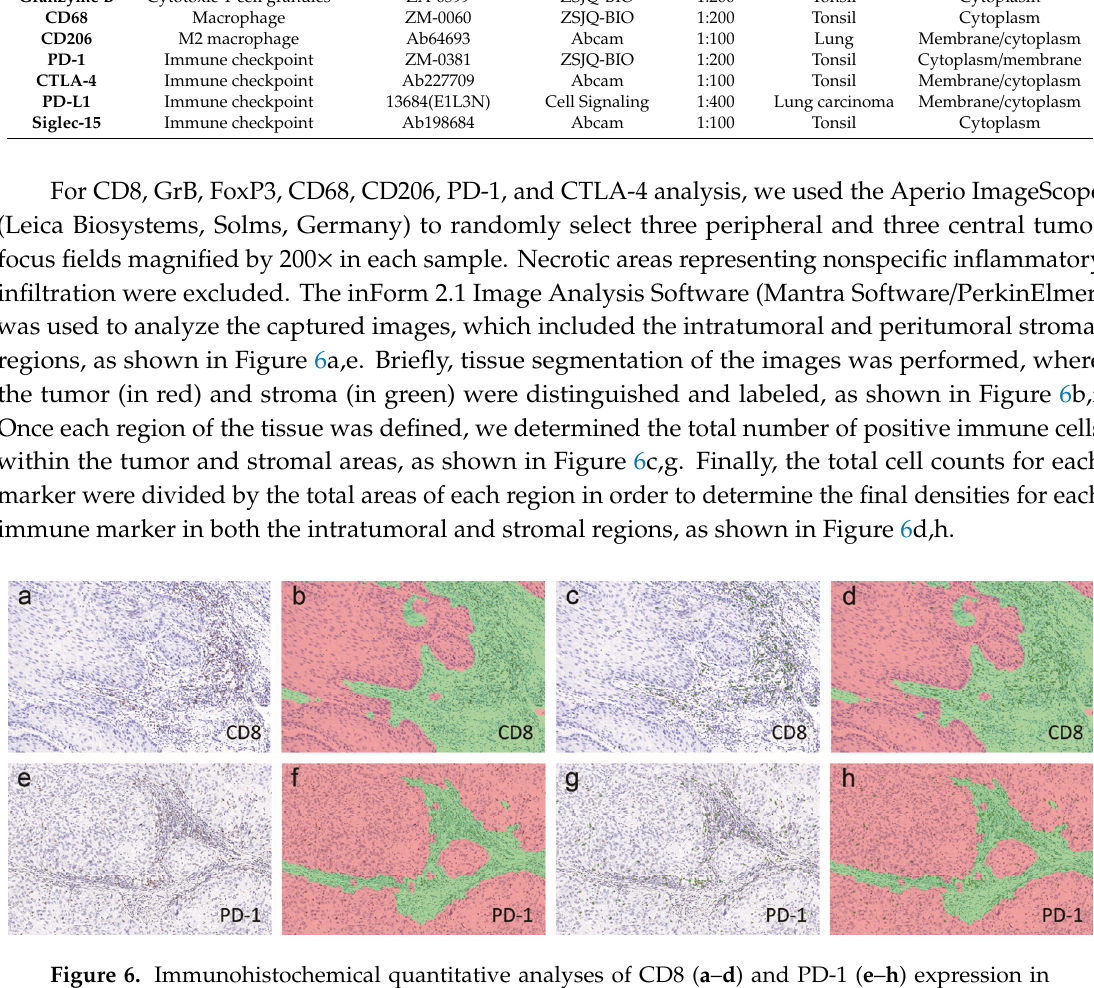
Figure 6. Immunohistochemical quantitative analyses of CD8 ( a – d ) and PD-1 ( e – h ) expression in intratumoral and stromal regions. Analyses were performed using inForm 2.1 Image Analysis Software (Mantra Software/PerkinElmer). Images of IHC staining, as well as the simulative tissue segmentation (tumor: red, stroma: green) ( b , f ), positive cell segmentation ( c , g ) and merged images ( d , h ), were shown. Magnification: 200×.